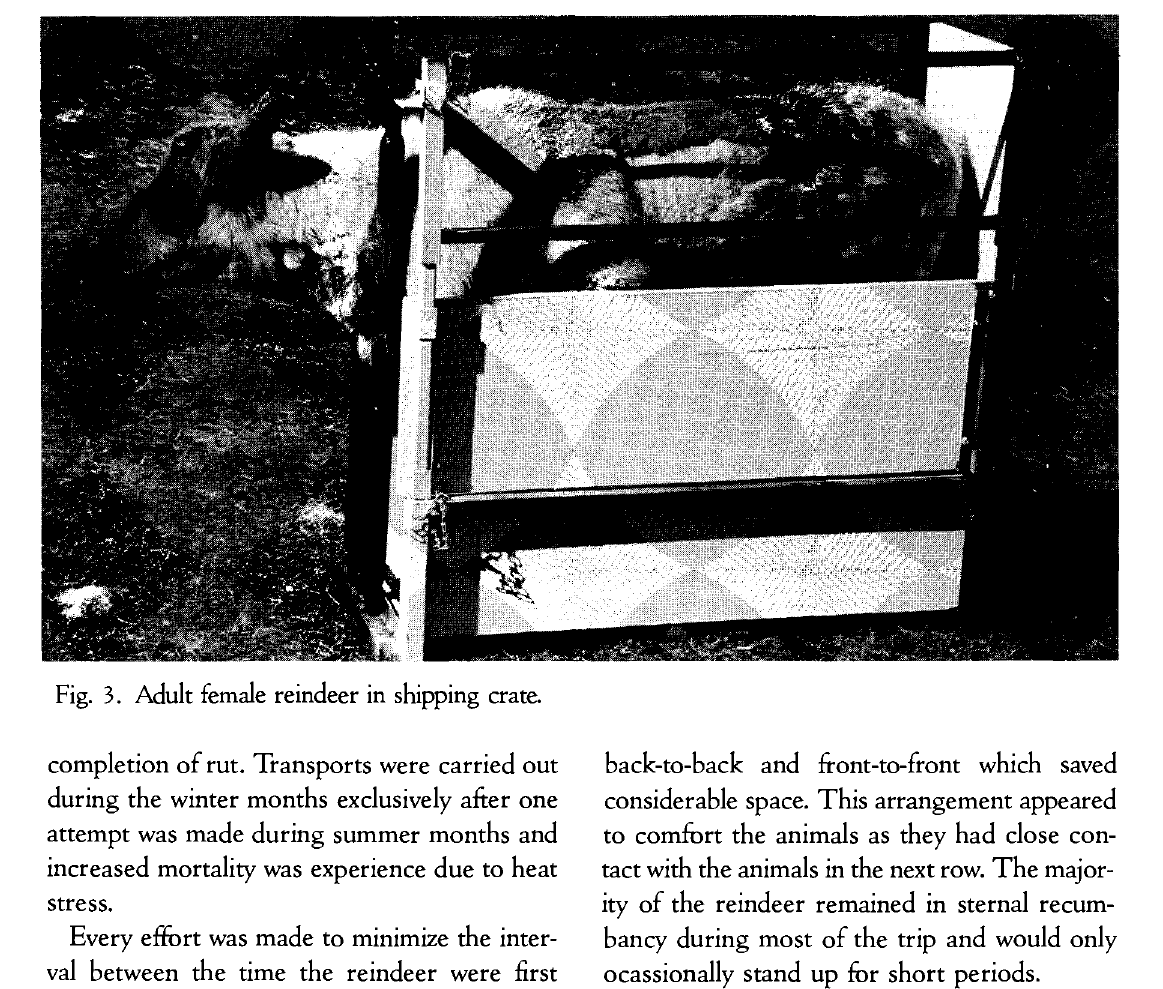
Fig. 3. Adult female reindeer in shipping